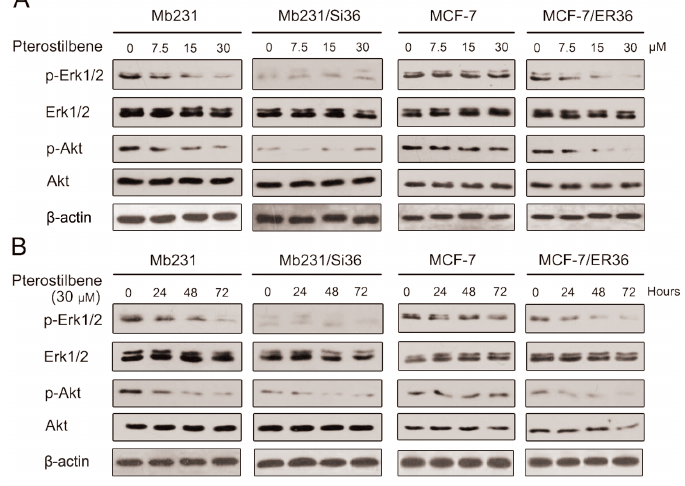
Figure 3. Pterostilbene inhibits the ERK1/2 and Akt activation via ER- a 36 in breast cancer cells. a . Mb231, Mb231/Si36, MCF-7, and MCF- 7/ER36 cells were treated with the indicated concentrations of pterostilbene for 72 h. b Mb231, Mb231/Si36, MCF-7, and MCF-7/ER36 cells were treated with 30 m M pterostilbene for the indicated hours. Changes in p-ERK1/2 and p-Akt protein levels were analyzed through western blotting. The total ERK1/2 and Akt proteins were used as loading